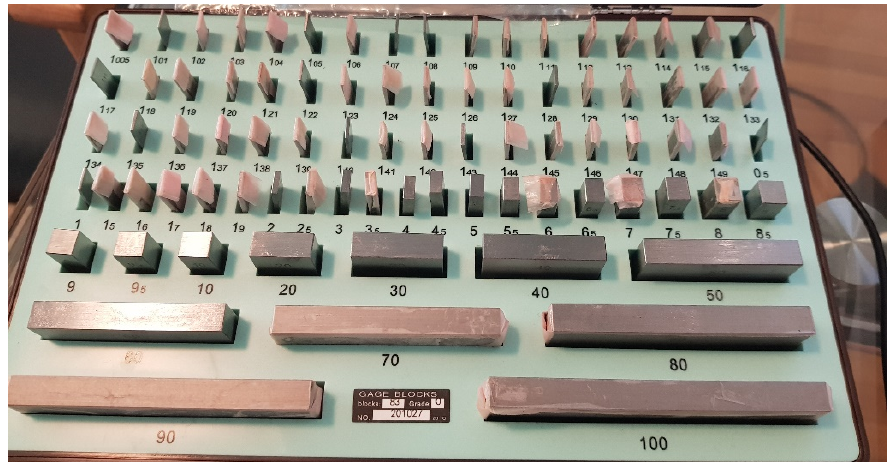
Figure 2. The gauge blocks.